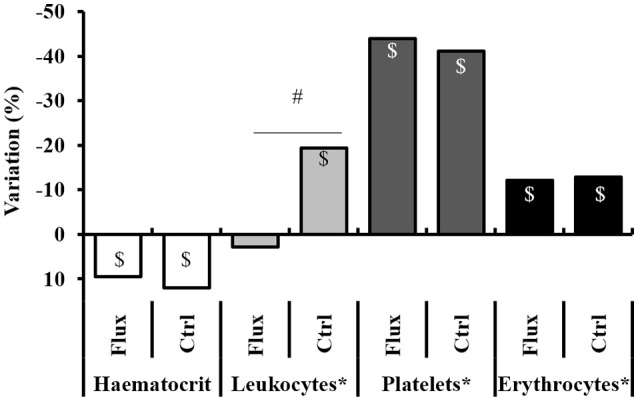
Full blood count variation, between before and after the hyperbaric exposure. Ctrl, control; Flux, Fluoxetine; ND, non-diver. *Corrected according to the individual hematocrit variation. $Significant difference (p < 0.05) between before and after the dive for the same parameter. #Significant difference (p < 0.05) between groups after the dive for the evolution of the same parameter.